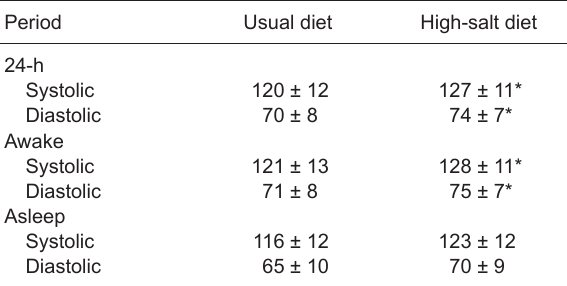
Table 1. Ambulatory 24-h blood pressure monitoring during the awake and asleep periods of elderly subjects on their usual diet and after a long-term (13 weeks) high-salt